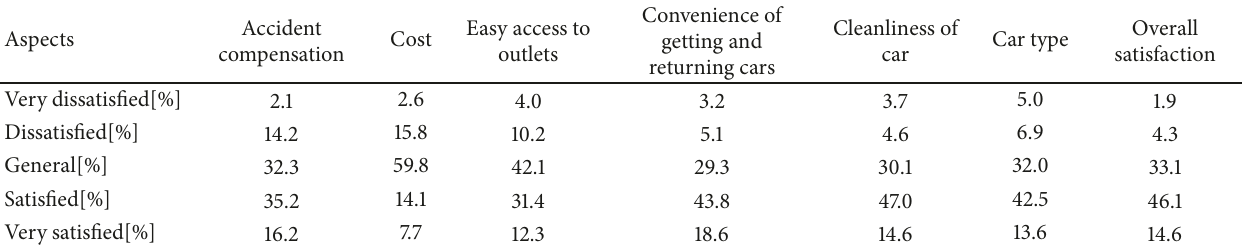
Table 8: Responses to satisfaction